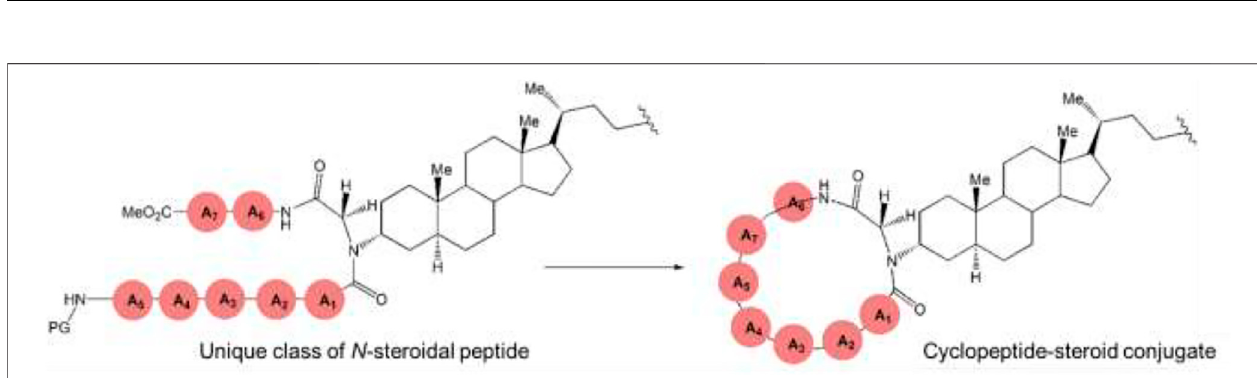
Frontiers in Chemistry |